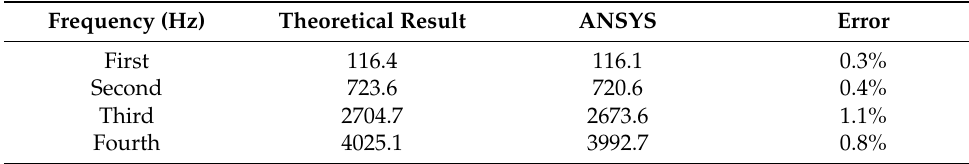
Figure 5. Comparison of the first-four vibration modes between theoretical and finite element results: ( a , b ) are the first vibration mode; ( c , d ) are the second vibration mode; ( e , f ) are the third vibration mode; ( g , h ) are the fourth vibration mode. Table 6. Comparison between theoretical and finite element